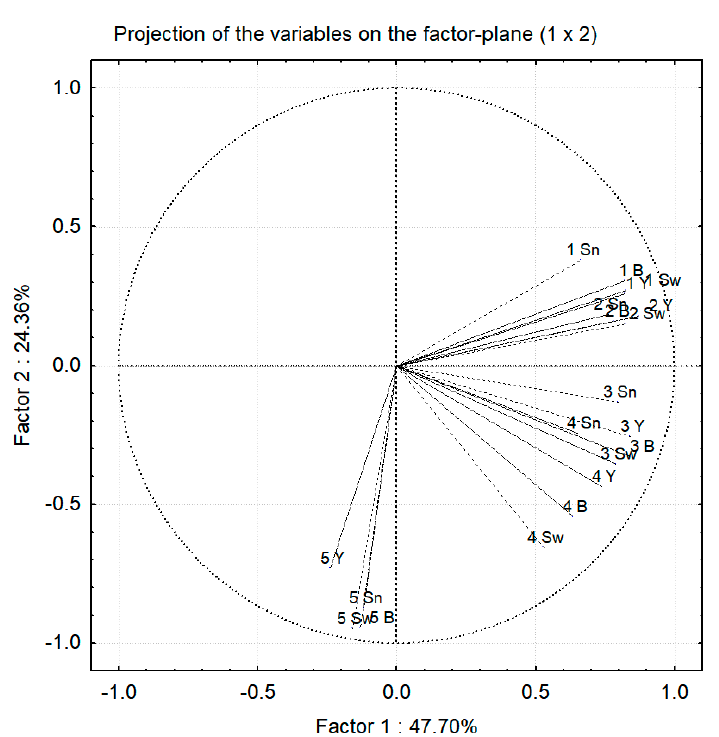
Figure 3. Principal component analysis (PCA), Projection of the variable on the factor plane (1 × 2). Y = Yield, B = Biomass, Sn = Spike number, Sw = Spike weight. 1, 2, 3, 4, 5 = cluster number.